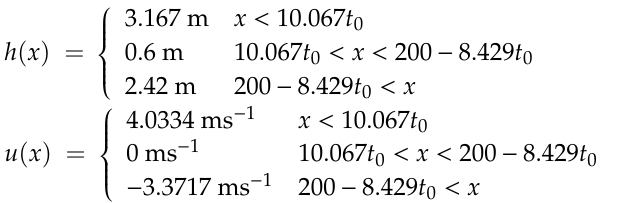
Figure 15. A sketch of the reservoir–conduct–reservoir model.